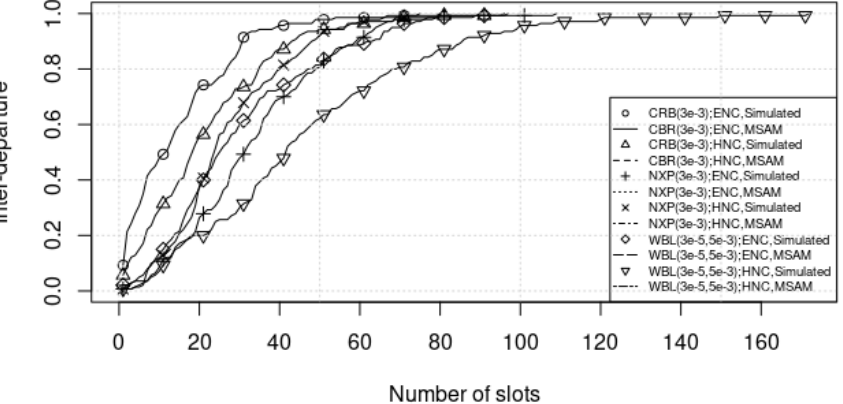
Figure 6. The Cumulative Distribution Functions of the inter-departure of packets.